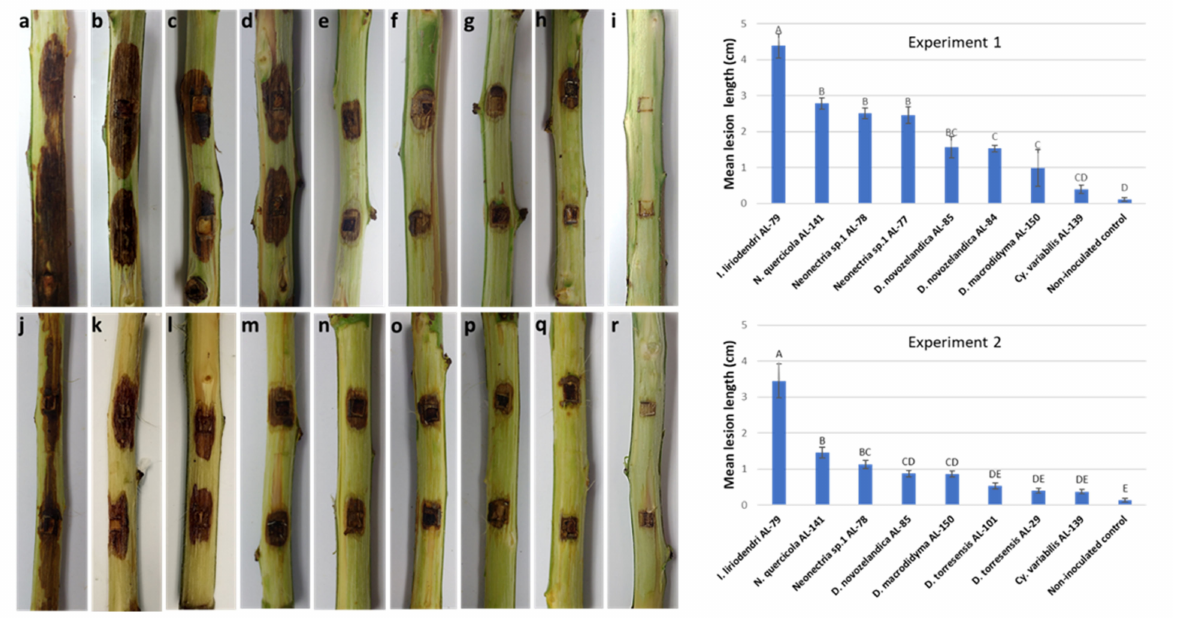
Figure 3. Lesions caused in detached ‘Guara’ almond twigs 15 days after inoculation with Cylindro- carpon -like anamorphs: Ilyonectria liriodendri AL79 isolate ( a , j ); Neonectria quercicola AL141 isolate ( b , k ); Neonectria sp. 1 AL78 ( c , l ) and AL77 ( d ) isolates; Dactylonectria novozelandica AL85 ( e , m ) and AL84 ( f ) isolates; D. macrodidyma AL150 isolate ( g , n ); D. torresensis AL101 ( o ) and AL29 ( p ) isolates; Cylindrocladiella variabilis AL139 isolate ( h , q ), and non-inoculated control ( i , r ). Two independent experiments are shown with some differences in the isolates tested. Results are the mean of 16 inoc- ulation points (eight twigs and two wounds per twig) per isolate and error bars correspond to the standard error. Data were subjected to analysis of variance (ANOVA) and different letters indicate significant differences according to the LSD test at p < 0.05.